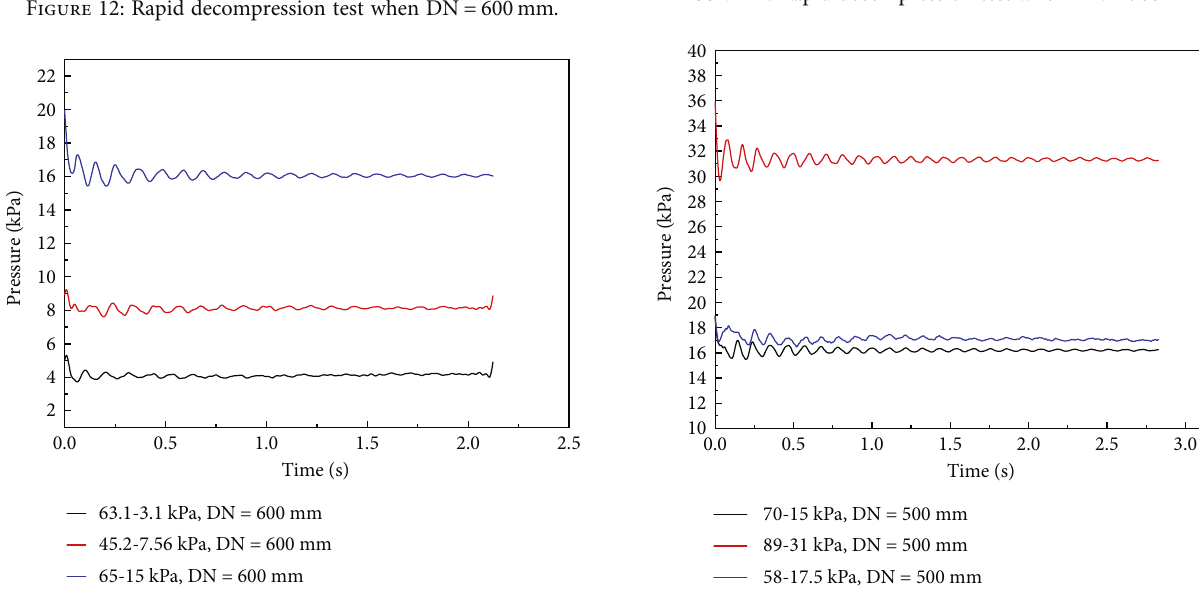
Figure 14: Rapid decompression test when DN = 500mm .